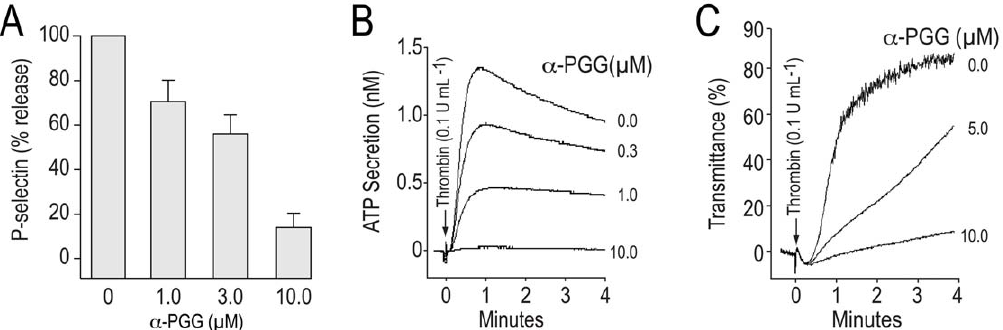
Figure 3. a -PGG inhibited thrombin induced secretion from the a - and dense-granules and platelet aggregation. Washed human platelets were stimulated with thrombin (0.1 U mL 2 1 ) in the presence or absence of a -PGG and expression of P-selectin (A) and secretion of ATP (B) and platelet aggregation (C) was monitored as detailed in Experimental Procedures. The results are reported as means 6 SD for P-selectin expression (n=3). ATP secretion and aggregation tracings are representative of three experiments.